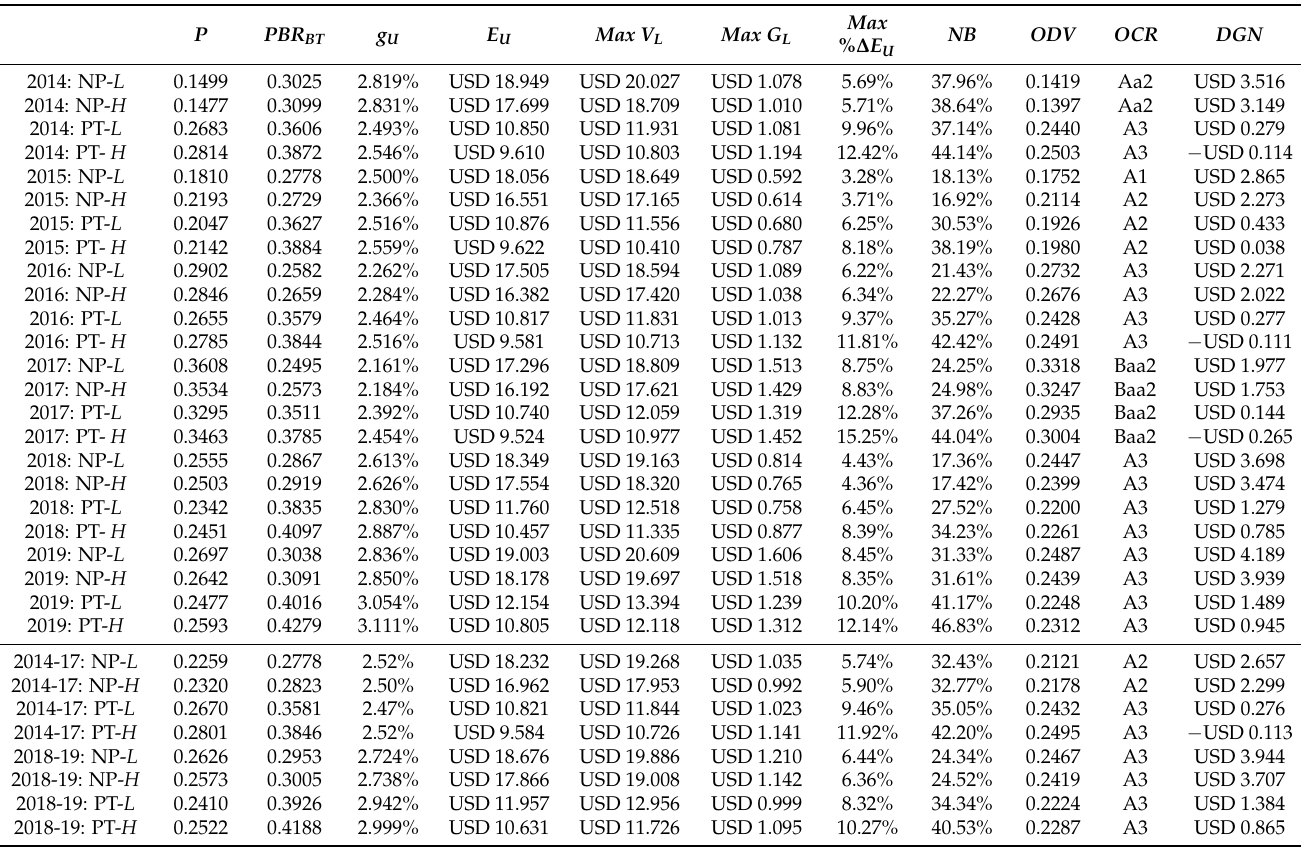
Table 6. Optimal Outcomes for NPs and PTs with Adjustments for Pre-TCJA Tax Rates and TCJA